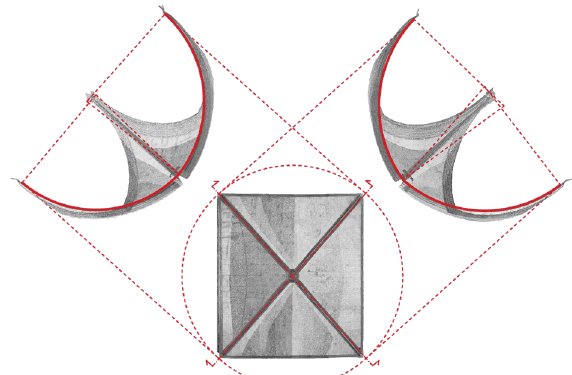
Figure 14 . Definition of curvatures and centres of diagonal arches of one of the vaults of Santa Lucia.